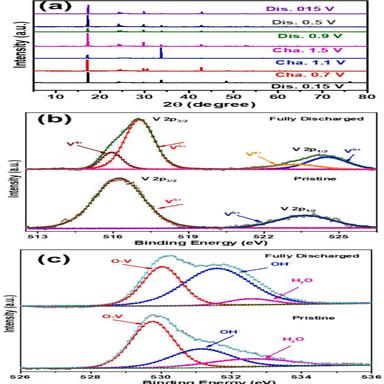
(a) Ex-situ XRD patterns at the selected potential states of the V2O5@MoS2–2 NCs electrode. XPS spectra of (b) V 2p and (c) O 1s at pristine and fully discharged states of the V2O5@MoS2–2 NCs.